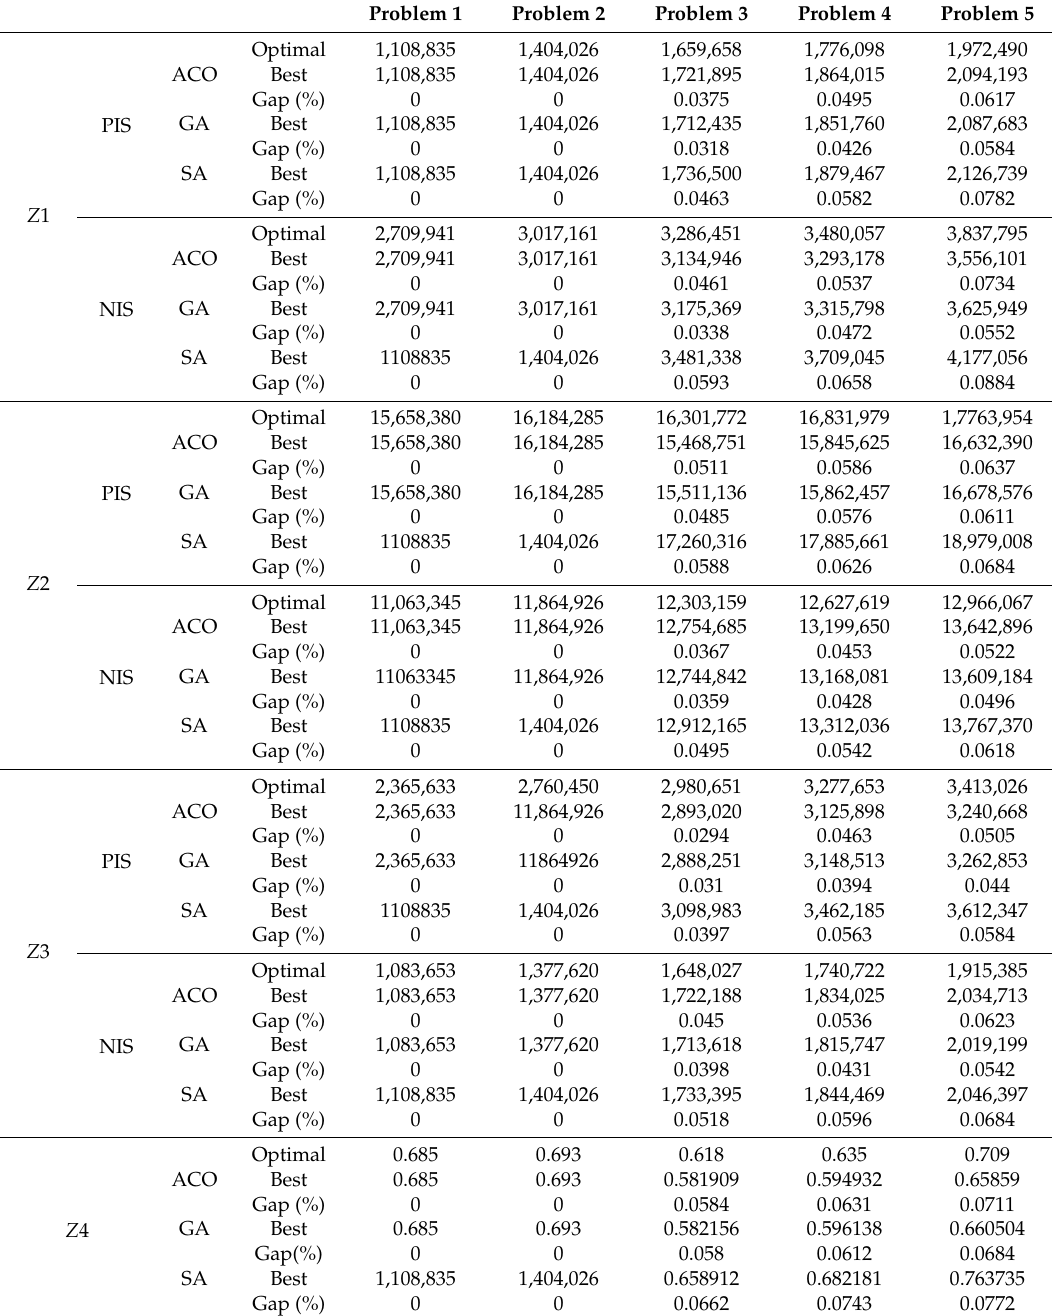
Table 4. Test problem